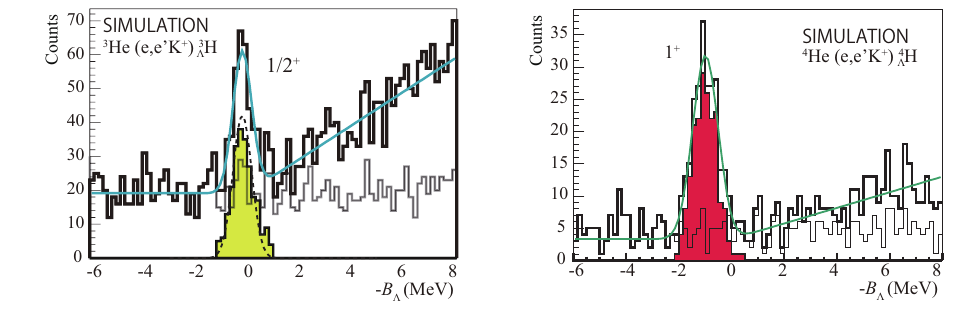
Figure 1. Expected spectrum for the 3 Λ H production in JLab E12-19-002.